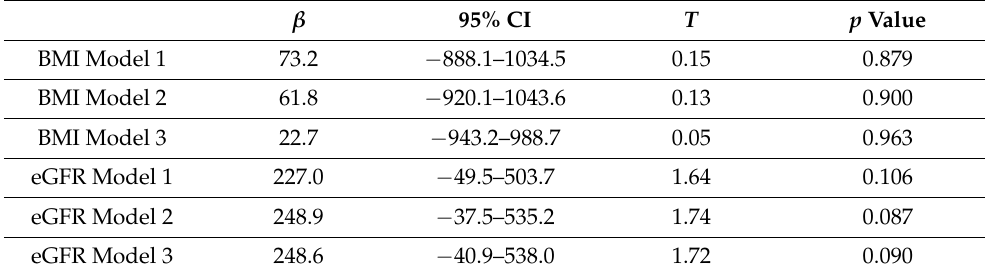
Table 3. Regression analysis for the increase in S-IgG titer from 5–6 months after 2 doses of vaccination to 3 doses of vaccination.